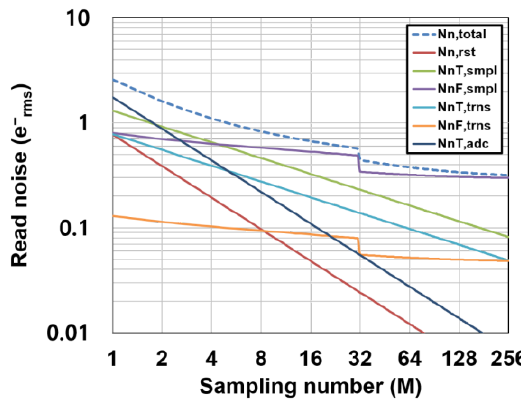
Figure 13. Measured noise as a function of the sampling number and the comparison with the noise calculated with the noise model.